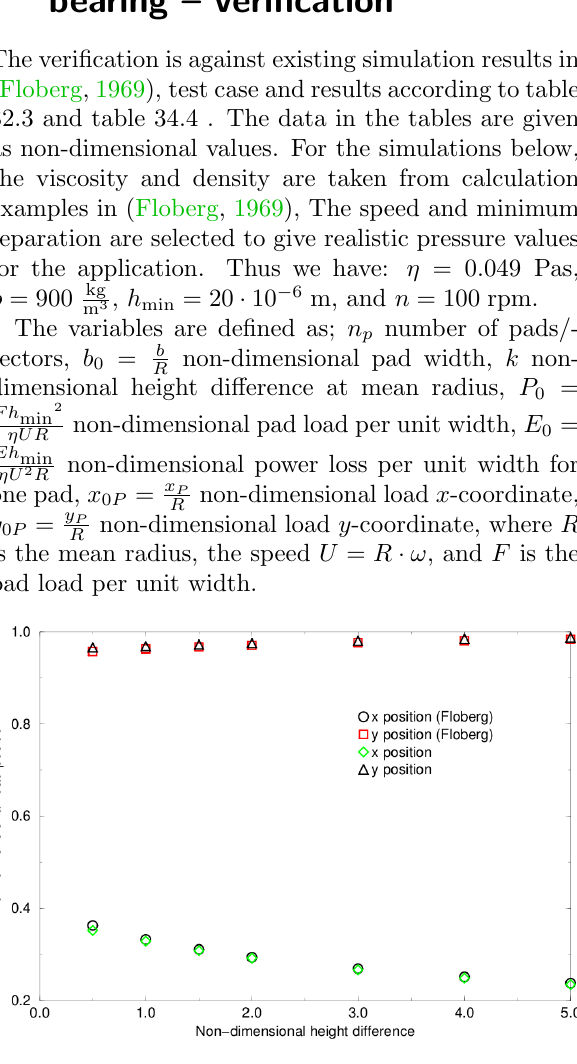
Figure 11: Load positions for sector-shaped tilting pad thrust bearing according to table 32.3 in (Floberg, 1969). Simulations, and calcula- tions from (Floberg,